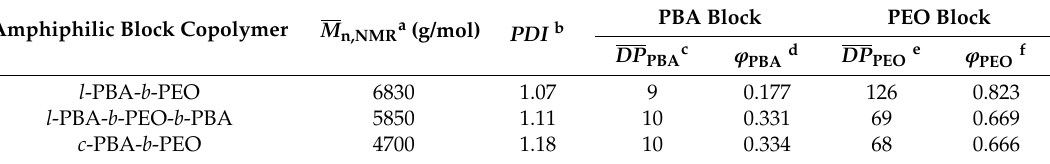
Table 1. Molecular characteristics, degree of polymerization, and volume fraction components of the block copolymers used in this